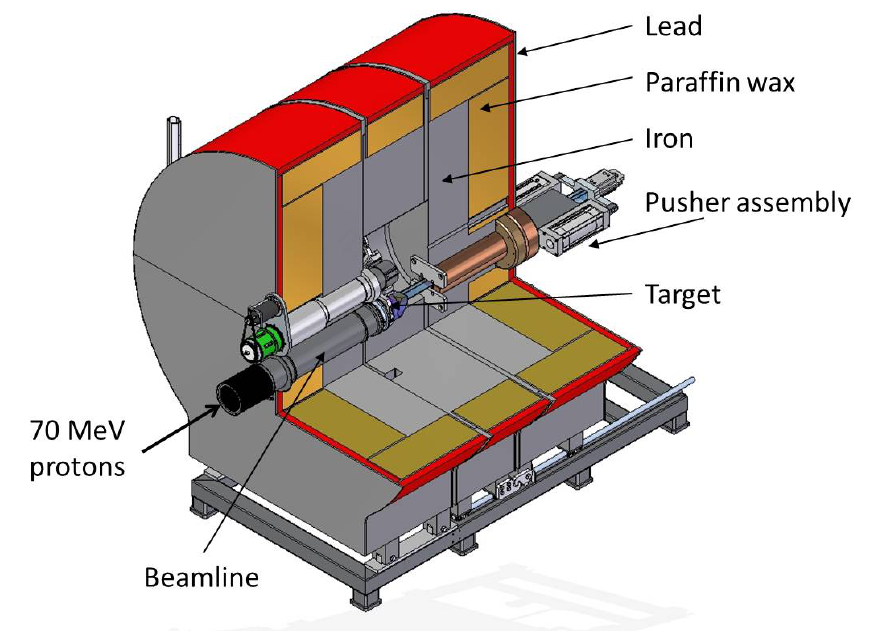
Figure 3. Cutaway view of the production station. The pusher assembly locates the target in the irradiation position and also connects the cooling-water lines. The beamline is 1.5 m above the